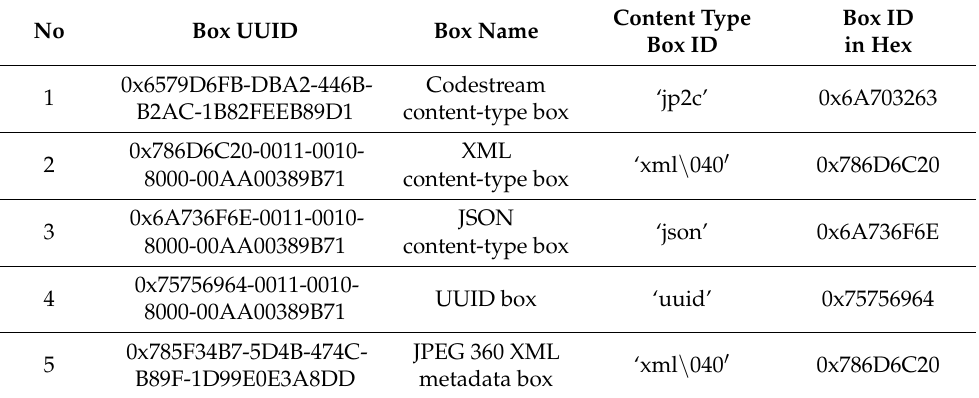
Table 3. Currently defined content type boxes in JPEG Systems.